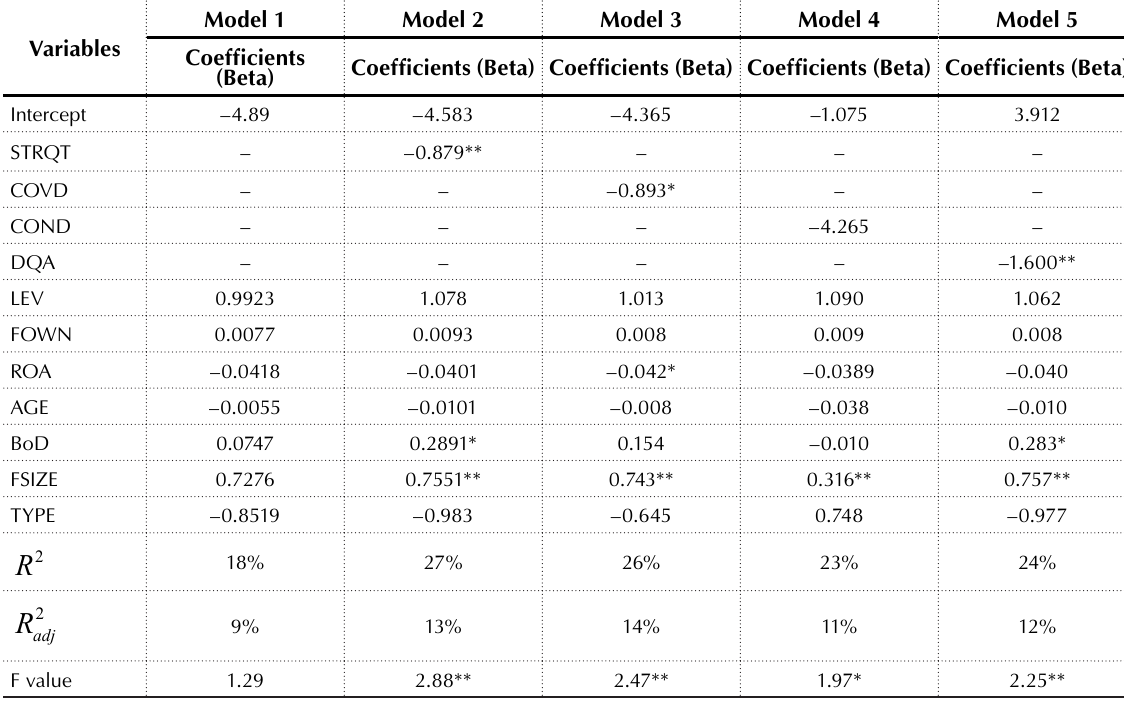
Table 6. Regression analysis of the study